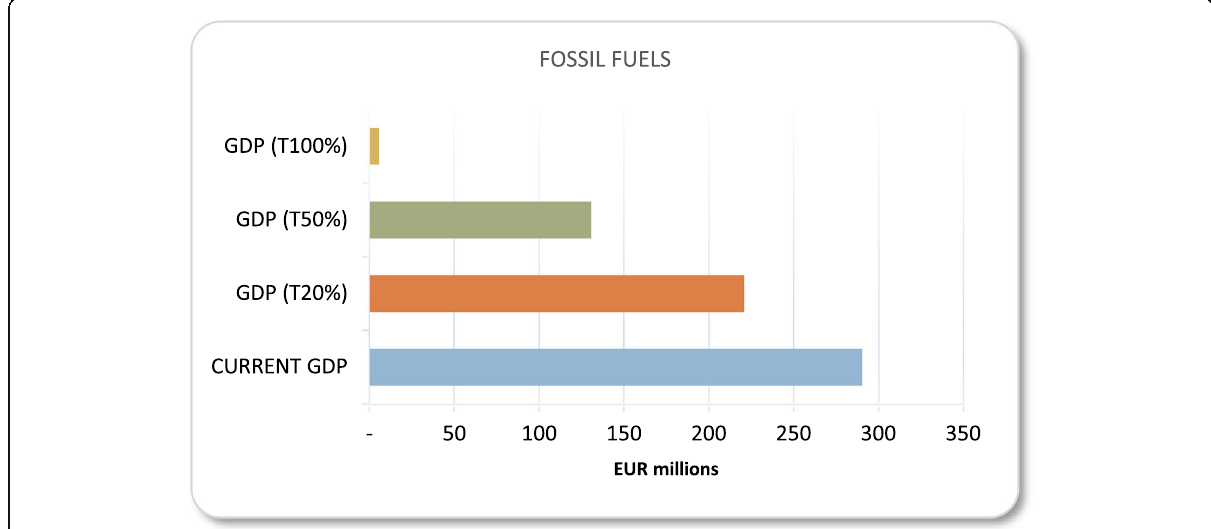
Fig. 21 GDP forecast of the Spanish fossil fuels energy